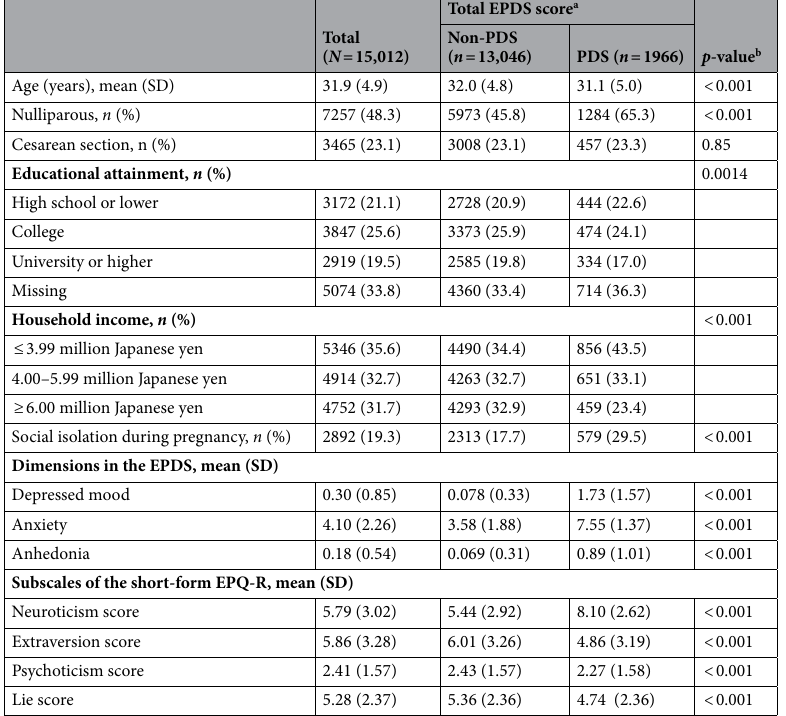
Table 2 presents the associations between personality scales and PDS assessed by the EPDS. Higher neu- roticism scores were associated with an increased risk of PDS; the multivariate-adjusted OR was 2.63 (95% CI, 2.48 to 2.79). Higher extraversion scores were associated with a decreased risk of PDS; the multivariate-adjusted OR was 0.74 (95% CI, 0.70 to 0.78). Higher psychoticism scores were associated with a decreased risk of PDS; the multivariate-adjusted OR was 0.89 (95% CI, 0.85 to 0.94). Higher lie scores were associated with a decreased risk of PDS; the multivariate-adjusted OR was 0.78 (95% CI, 0.75 to 0.82). Table 3 presents the associations between personality scales and underlying symptom dimension in the EPDS. Higher neuroticism scores were associated with an increased risk of depressed mood ( β , 0.20; 95% CI, 0.19 to 0.22), anxiety ( β , 0.91; 95% CI, 0.88 to 0.94), and anhedonia ( β , 0.087; 95% CI, 0.079 to 0.096). Higher extraversion scores were associated with a decreased risk of depressed mood ( β , − 0.056; 95% CI, − 0.070 to –0.042), anxiety ( β , − 0.31; 95% CI, –0.34 to –0.27), and anhedonia ( β , − 0.045; 95% CI, − 0.054 to − 0.037). Higher psychoticism scores were associated with a decreased risk of anxiety (β, − 0.25; 95% CI, − 0.28 to − 0.22), but not with depressed mood ( β , − 0.0088; 95% CI, − 0.022 to 0.0048) or anhedonia ( β , − 0.00044; 95% CI, − 0.0090 to 0.0082). Higher lie scores were associated with a decreased risk of depressed mood ( β , − 0.055;